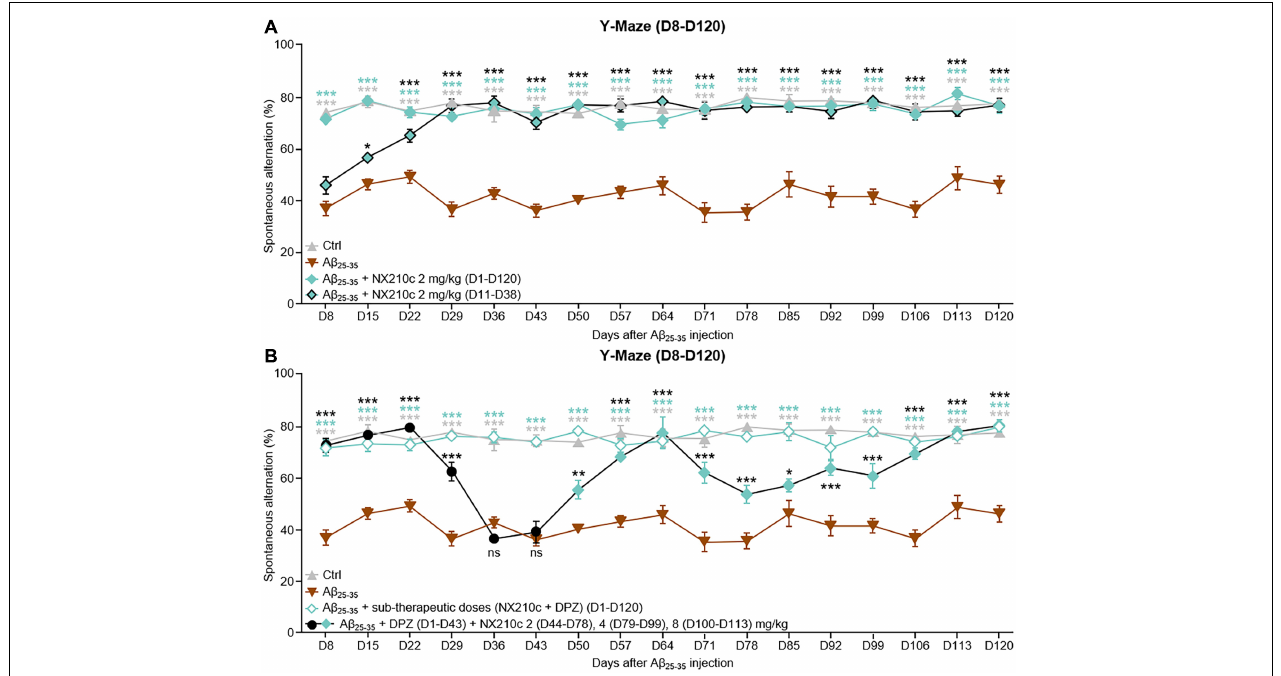
FIGURE 5 | Early- and late-stage daily treatments with NX210c prevent amyloid-beta 25 - 35 (A β 25 - 35 )-induced long-term cognitive impairments in mice. (A) Mice were injected intracerebroventricularly with scrambled control peptides (Ctrl) or A β 25 - 35 oligomers and treated intraperitoneally once a day with vehicle, NX210c (2 mg/kg) from day 1 (D1) to D120 or with NX210c (2 mg/kg) from D11 to D38. Spontaneous alternation in the Y-maze was assessed weekly from D8 to D120 to study spatial working memory. Early and late-stage daily treatment with NX210c restored working memory deficit, as shown by the increased number of spontaneous alternations in the Y-maze compared with A β 25 - 35 -injected mice treated with vehicle. The data are presented as means and SEM. Two-way ANOVA followed by Tukey’s multiple comparisons test: *** p < 0.001, * p < 0.05 compared with A β 25 - 35 , n = 5 Ctrl, A β 25 - 35 , n = 6 A β 25 - 35 + NX210c (D1–D120), A β 25 - 35 + NX210c (D11–D38). (B) Mice were injected intracerebroventricularly with scrambled control peptides (Ctrl) or A β 25 - 35 oligomers, and treated intraperitoneally once a day with vehicle, NX210c (0.1 mg/kg) along with donepezil (DPZ, 0.25 mg/kg) administered orally from D1 to D120, or successively with DPZ (1 mg/kg, D1–D43) and NX210c (2 mg/kg, D44–D78; 4 mg/kg, D79–D99; 8 mg/kg, D100–D113). Spontaneous alternation in the Y-maze was assessed weekly from D8 to D120 to study spatial working memory. Early stage daily treatment with a combination of sub-therapeutic doses of donepezil and NX210c restored working memory deficit, as shown by the increased number of spontaneous alternations in the Y-maze compared with A β 25 - 35 -injected mice treated with vehicle. Late-stage daily treatment with NX210c rescued donepezil loss of efficacy on working memory deficit. The data are presented as means and SEM. Two-way ANOVA followed by Tukey’s multiple comparisons test: *** p < 0.001, ** p < 0.01, * p < 0.05 compared with A β 25 - 35 , n = 5 Ctrl, A β 25 - 35 , n = 6 A β 25 - 35 + (NX210c + DPZ) (D1–D120), A β 25 - 35 + DPZ + NX210c.